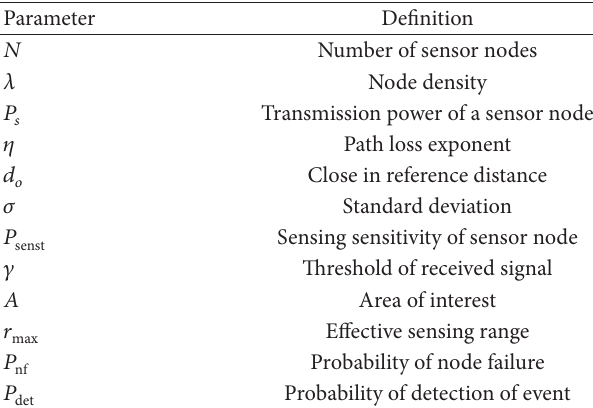
Table 1: Parameters definitions.